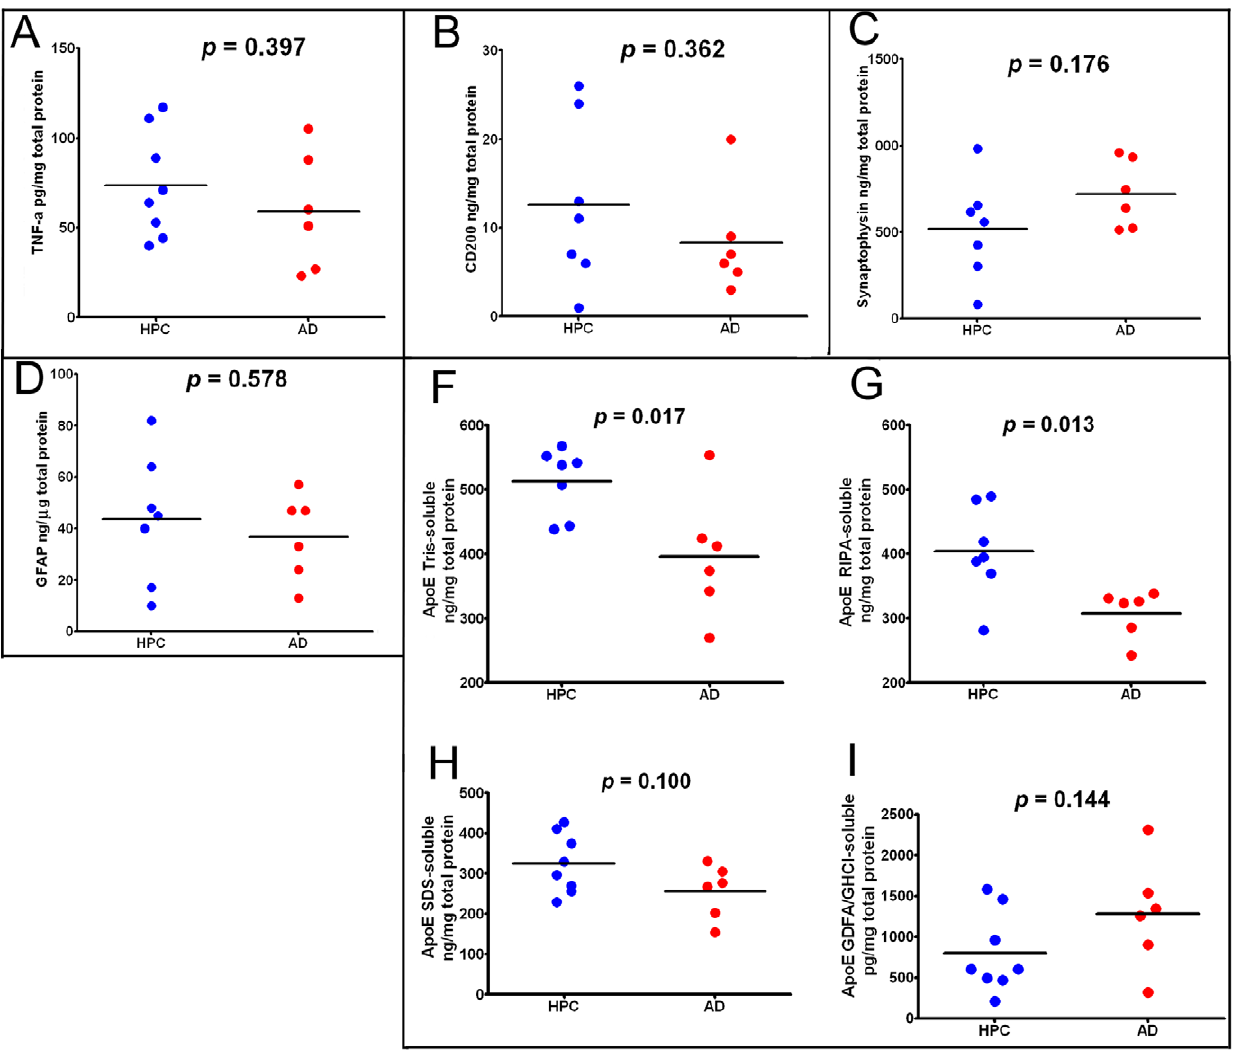
Figure 4. ELISA scatter plots of frontal lobe gray matter proteins. A ) TNF- a homogenized in HEPES buffer; B ) CD200 homogenized in RIPA buffer; C ) Synaptophysin homogenized in RIPA buffer; D ) GFAP homogenized in RIPA buffer; F ) ApoE homogenized in Tris buffer; G ) ApoE homogenized in RIPA buffer; H ) ApoE homogenized in 5% SDS buffer; I ) ApoE homogenized in GDFA/GHCl. All values were adjusted for total protein. The statistical analysis used was an unpaired, 2-tailed t-test. TNF- a = tumor necrosis factor-alpha; GFAP = glial fibrillary acid protein; ApoE = apolipoprotein E; GDFA = glass distilled formic acid; GHCl = guanidine hydrochloride; HPC = non-demented high pathology controls; AD = Alzheimer’s disease.